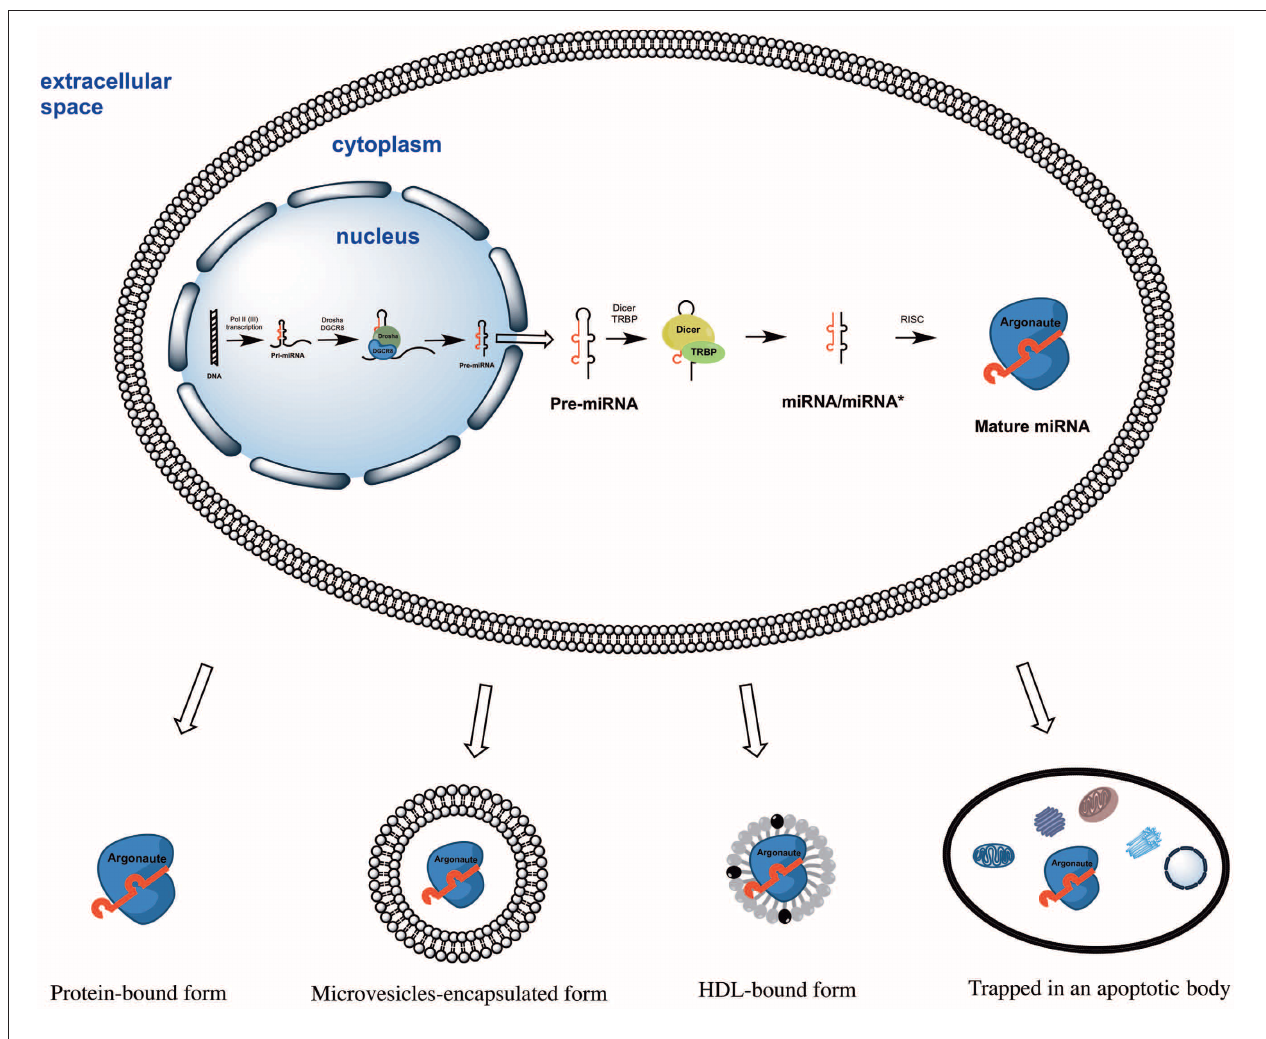
incorporated into a protein of the Argonaute family (AGO1, AGO2, AGO3, or AGO4). The mature miRNA strand eventually serves as the guide for RISC-mediated mRNA targeting resulting in either mRNA cleavage or translational interference. Extracellular miRNA can be either solely AGO protein-associated or additionally encapsulated into apoptotic bodies, microvesicles, and HDL